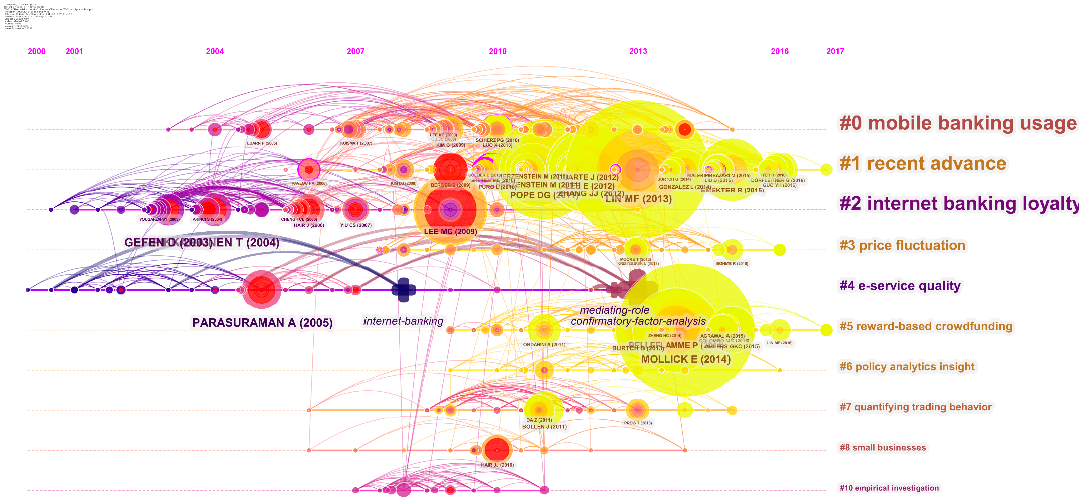
Figure 4. Time-line form of the co-cited network.